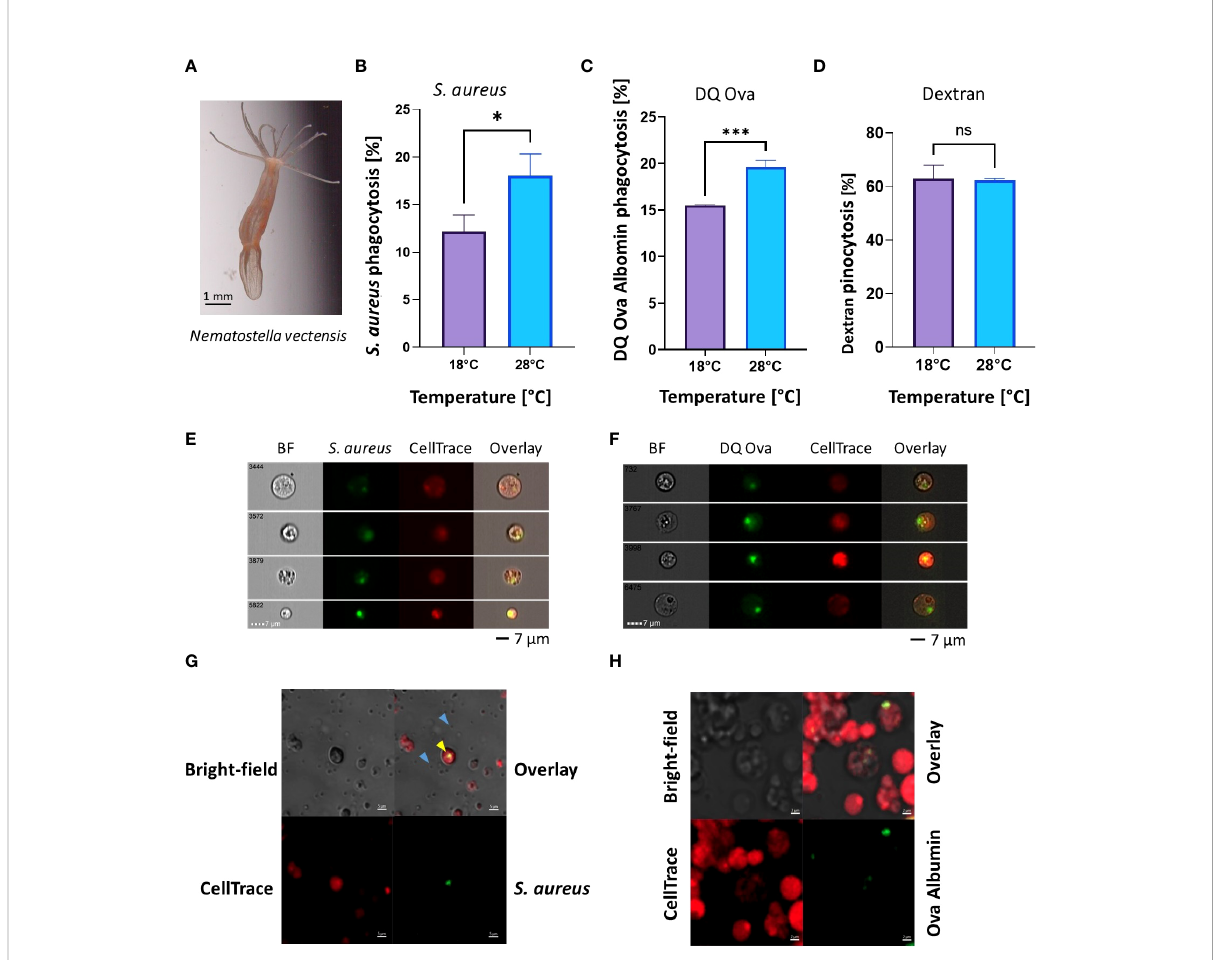
FIGURE 2 Phagocytic activity increases in heat-stress conditions, while pinocytosis remains unchanged in N. vectensis . (A) N. vectensis imaged by ZEISS Axiocam 208 Color Microscope Camera. (B, C) Phagocytosis of S. aureus bioparticles and DQ ovalbumin, respectively, under heat stress conditions of 28°C, increased signi fi cantly from the ambient treatment (18°C). (D) Pinocytosis of dextran under heat stress did not signi fi cantly change between ambient and heat stress conditions. (E) ImageStream analysis of cells that have engulfed S. aureus particles. The green fl uorescence is emitted from the S. aureus particles, but only when in low-pH vesicles; red fl uorescence is from the CellTrace cell stain. (F) ImageStream analysis of cells that have engulfed DQ ovalbumin. The green fl uorescence is emitted from the DQ ovalbumin conjugation with BODIPY, but only once hydrolysis into single peptides has occurred. A Student ’ s T-Test analysis was performed on the phagocytic and pinocytic assays between the ambient and elevated temperatures. (G) Confocal images of N. vectensis cells challenged with inactive pHrodo ™ S. aureus bioparticles (blue arrows), with cells having internalized pH-activated bioparticles in green (yellow arrow). (H) Confocal images of N. vectensis cells challenged with DQ ovalbumin, upon protease activity DQ ovalbumin fl uoresces in green. A Student ’ s t-test analysis was performed on the phagocytosis and the pinocytosis assays comparing the ambient and elevated temperatures. P-value legend: ns, Not signi fi cant, *: p <0.05, ***: p < 0.001. Scale bar represents standard deviation